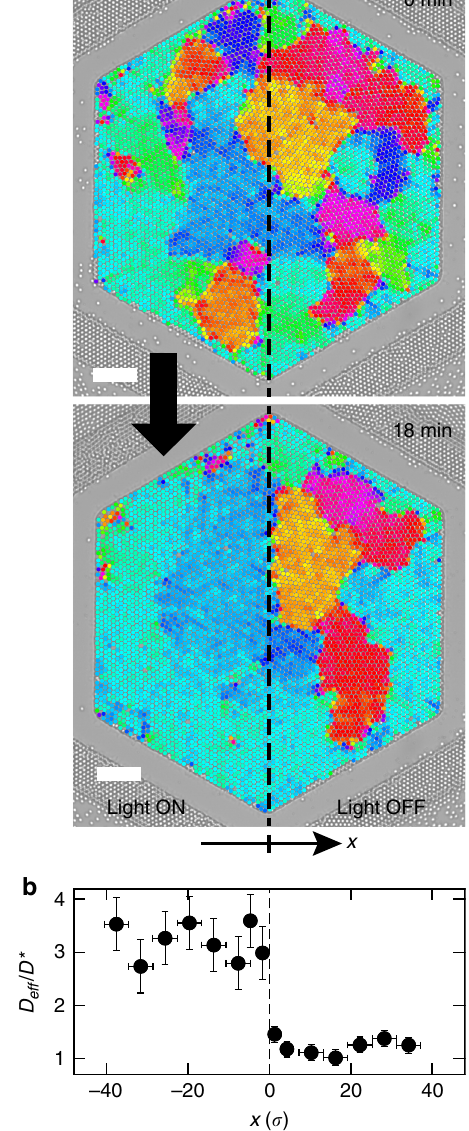
Fig. 4 Spatial control of the annealing. a Selective reorganization of the polycrystalline layer by activating only the intruders in the left half of the well. Scale bars, 50 μ m. b Diffusivity of the passive particles D eff compared to that in a thermal system D * , and plotted as a function of the distance to the illumination interface expressed in units of diameter. It illustrates dynamical control with a spatial resolution of only a few colloids. Vertical errorbars denote the standard deviation over particles located within each spatial window, whose boundaries are shown through horizontal